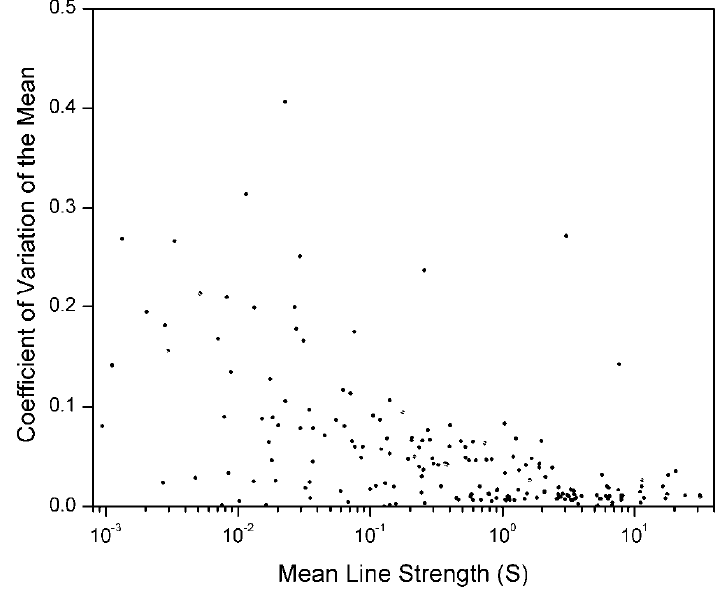
Figure 1. The mean line strength ((cid:1845)̅) vs. the Coefficient of Variation of the mean, (cid:1829) (cid:3023)(cid:3041) , for radiative transition rates in Na III for which the energy of the upper level is greater than 415, 000 cm − 1 . Seven outliers, three of which are off the scale, were given very small weights. Because only two data sources are used, the (cid:1829) (cid:3023)(cid:3041) for each transition is given by Equation